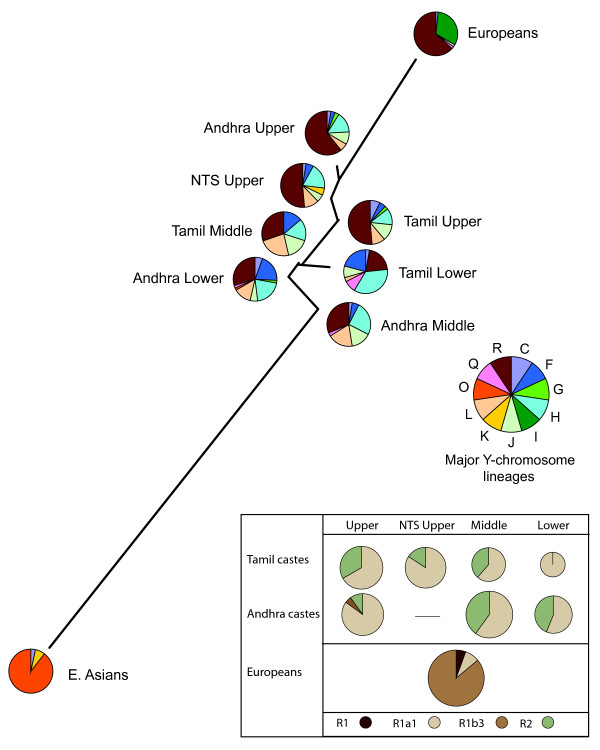
Genetic distances for Y-chromosome data. A neighbor-joining network depicts the genetic distance estimates between South Indian castes, Europeans, and East Asians for 32 Y-chromosome SNPs. The pie diagrams indicate the proportion of each major Y-chromosome lineage found in each population. The inset shows the proportions of Y-chromosome R sub-lineages. Inset circle size is proportional to the total number of R lineages.